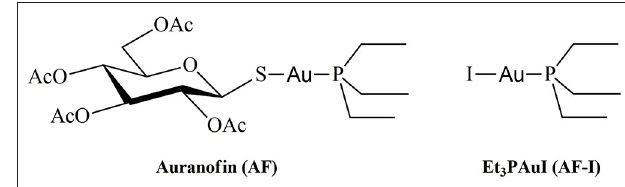
FIGURE 1 | Chemical structures of Auranofin (AF) and Iodo(triethylphosphine)gold(I) (AF-I).